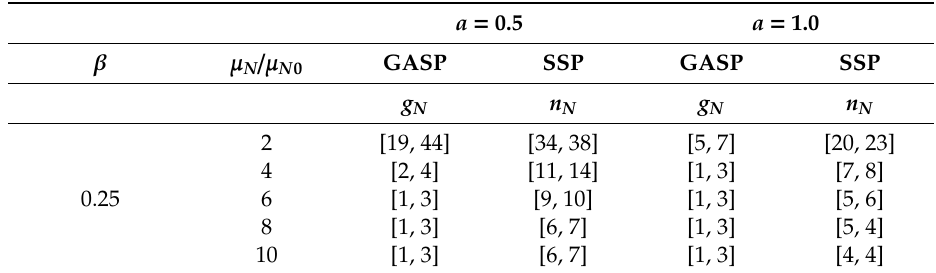
Table 6. Values of the proposed GASP and single-sampling plan (SSP) under neutrosophic statistics when r N = [10, 12] and δ N = [0.9,